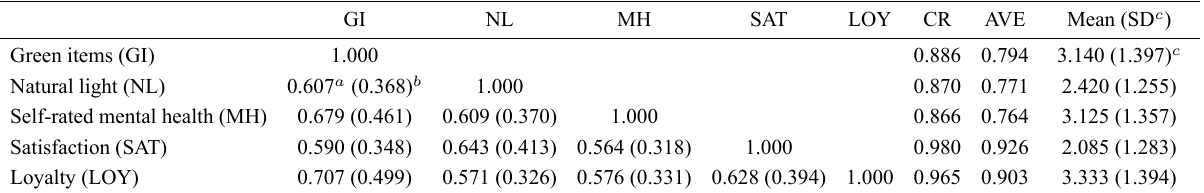
Table 2. Measurement model assessment (for male respondents).